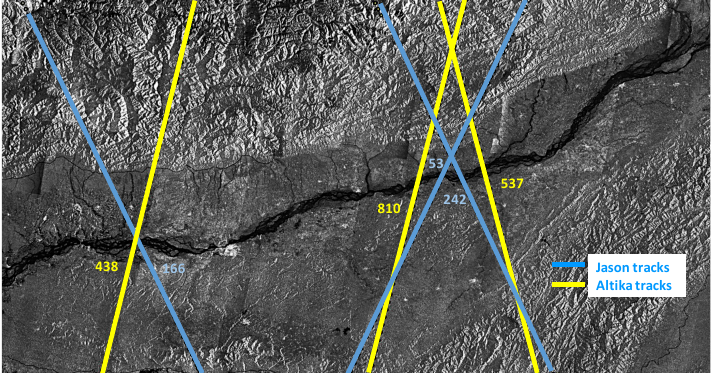
Figure 15. Brahmaputra river along with Jason-2 and SARAL/AltiKa tracks taken for the comparative analysis.